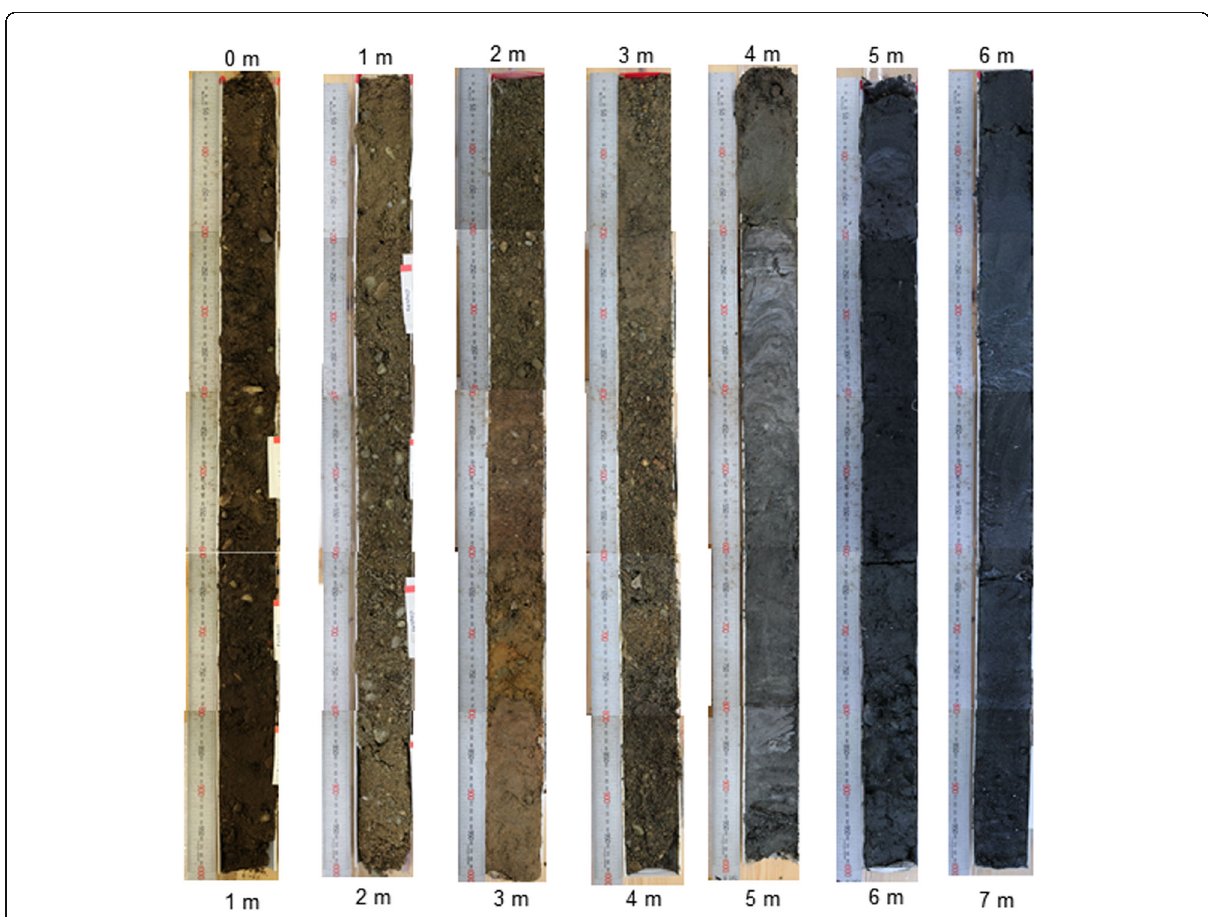
Fig. 10 Photograph of the core from site